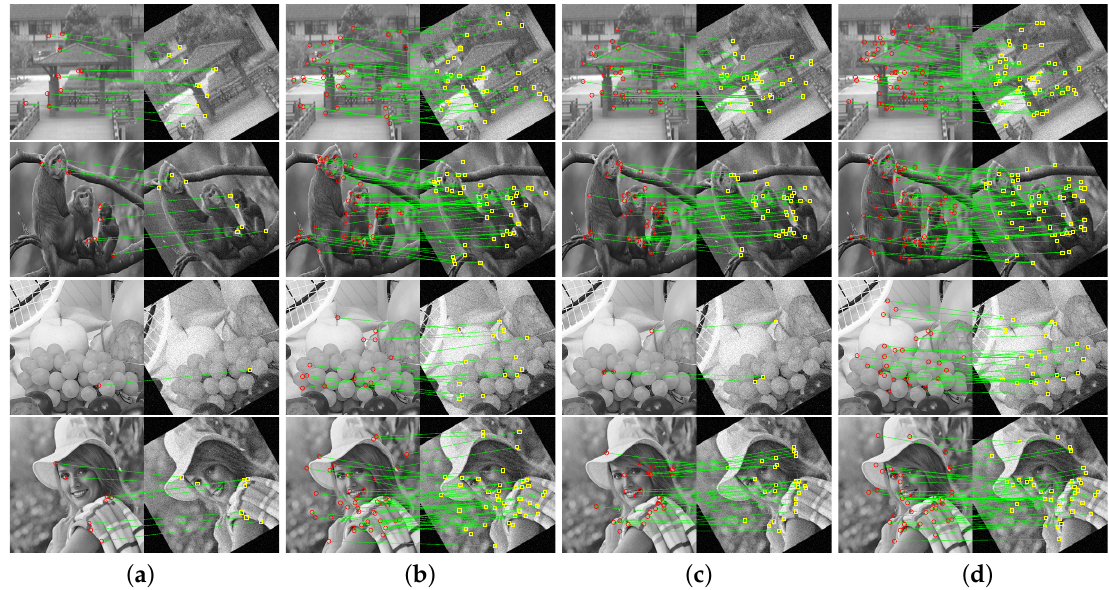
Figure 8. Matching results of rotated and noised images: ( a ) Harris results; ( b ) SIFT results; ( c ) PCA-SIFT results; ( d ) our results.